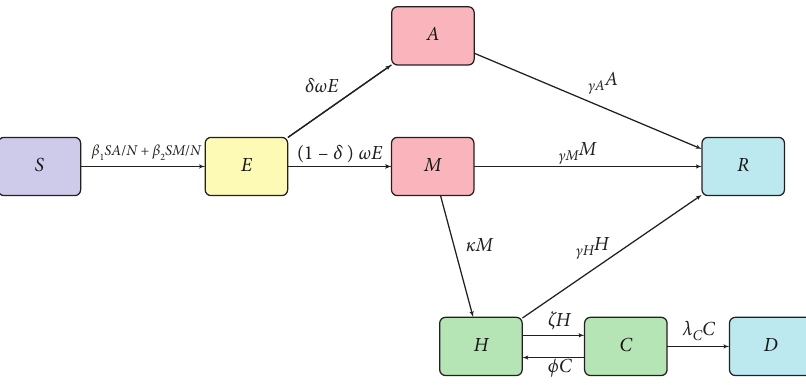
Figure 1: SEIR model flowchart. Table 1: Parameters of the SEIR model of